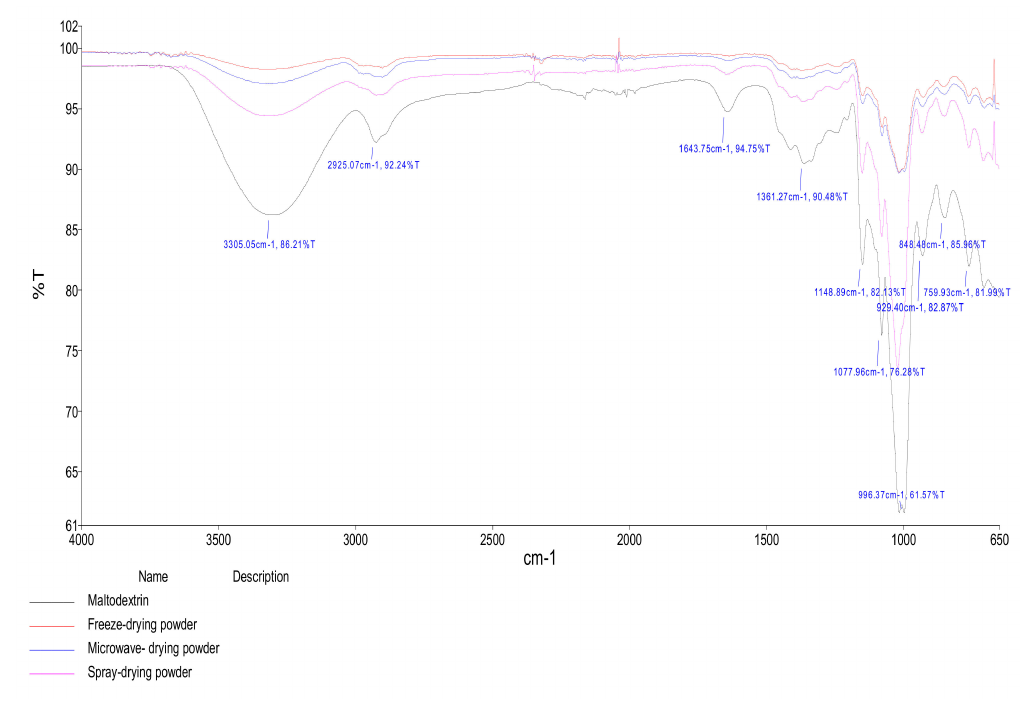
Figure 8. FTIR diagrams of maltodextrin and encapsulated